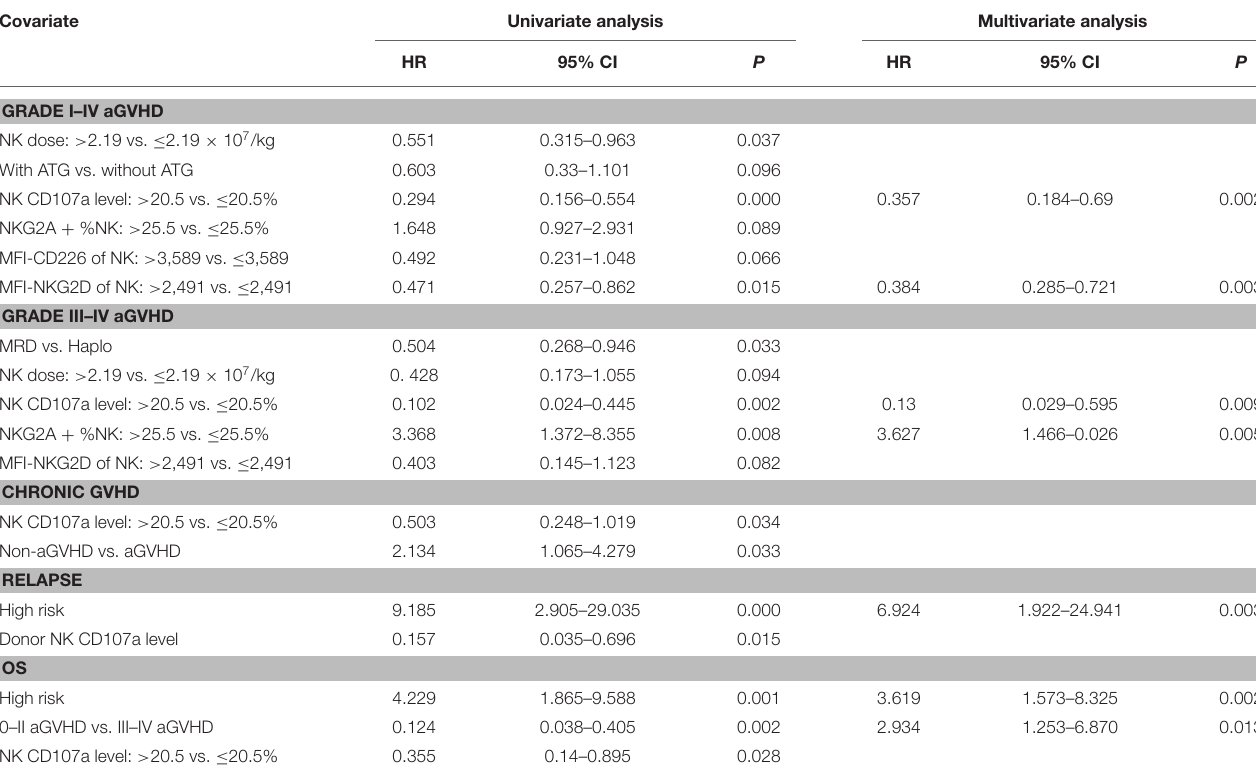
TABLE 2 | Univariate and multivariable analysis of risk factors for clinical outcomes of allogeneic stem cell transplantation. Covariate Univariate analysis Multivariate analysis HR 95%